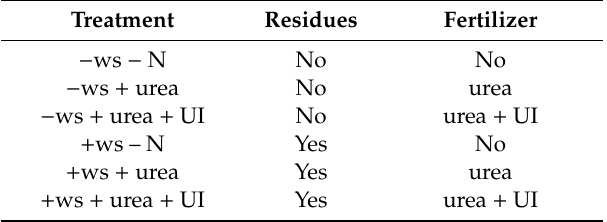
Table 1. 2-factorialdesignoftreatmentsinthe1st(determinationofmineralization)and2nd(determination of gaseous flux) experiments. Wheat residues (ws) were incorporated into the soil, and fertilizer granules without or with urease inhibitor (UI) were applied to the surface of individual